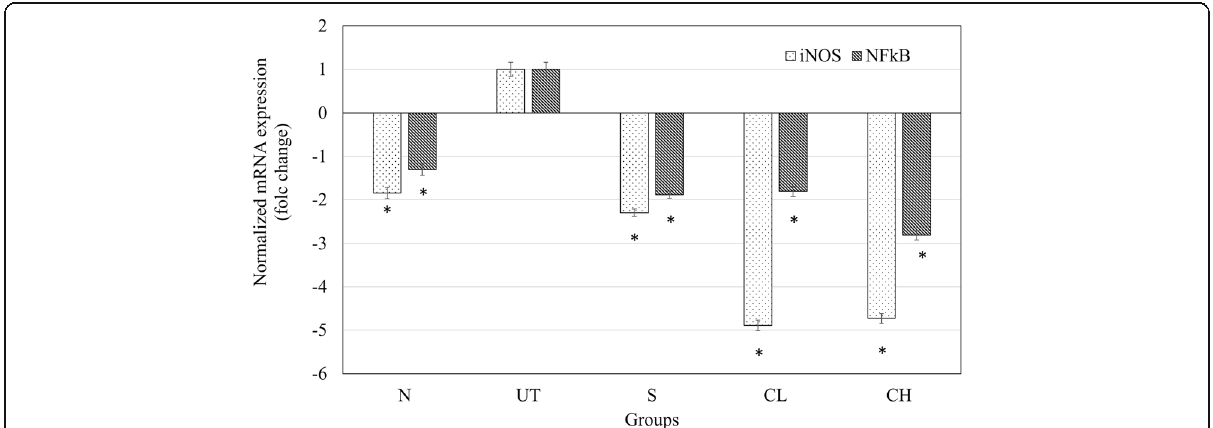
Fig. 4 Effect of coconut water vinegar on normalized mRNA expression of iNOS and NF-kB in liver of acetaminophenchallenged mice. All values are expressed as means mean ± SD of 6 mice in each group. * P < 0.01 as compared with the untreated control group. N: normal healthy control; UT: untreated acetaminophen-induced control; S: acetaminophen-induced treated with 50 mg/kg silybin; CL: acetaminophen-induced treated with 0.08 ml/kg coconut water vinegar; CH: acetaminophen-induced treated with 2 ml/kg coconut water vinegar